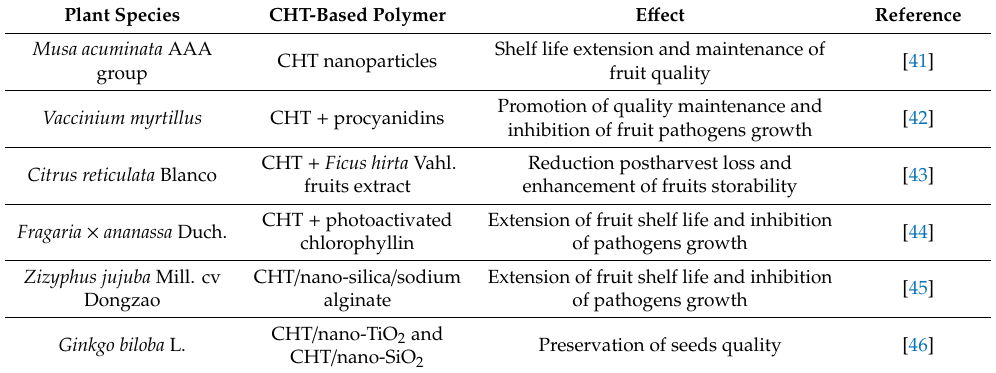
Table 4. Recent application of chitosan-based polymers and nanoparticles for fruits and seeds